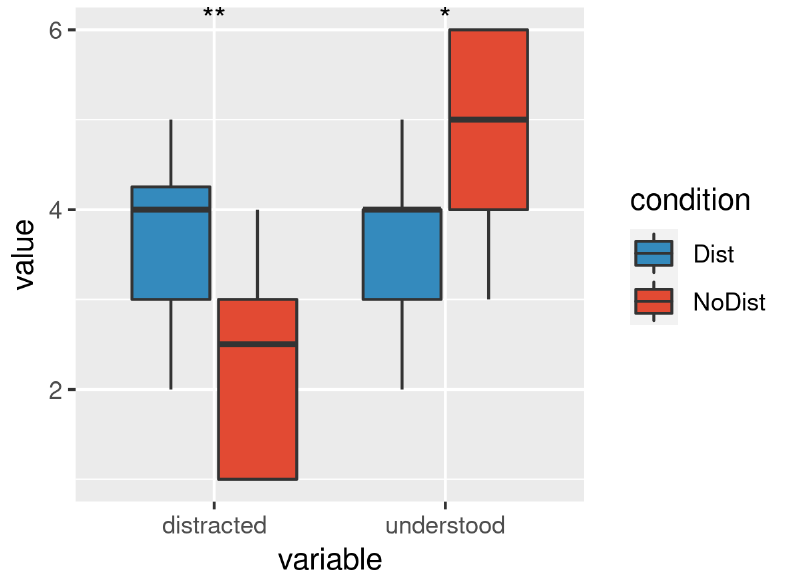
Figure 8. Perception of the distractions (significance level *: p < = 0.05, **: p < = 0.01